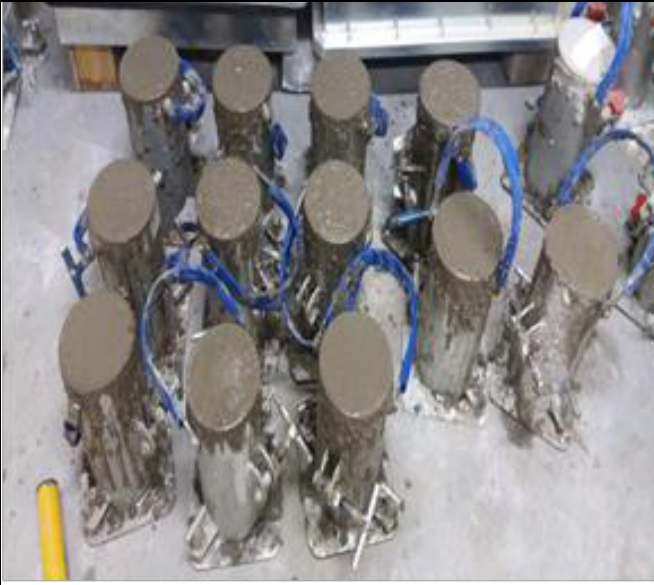
Figura 5: Moldagem dos corpos de